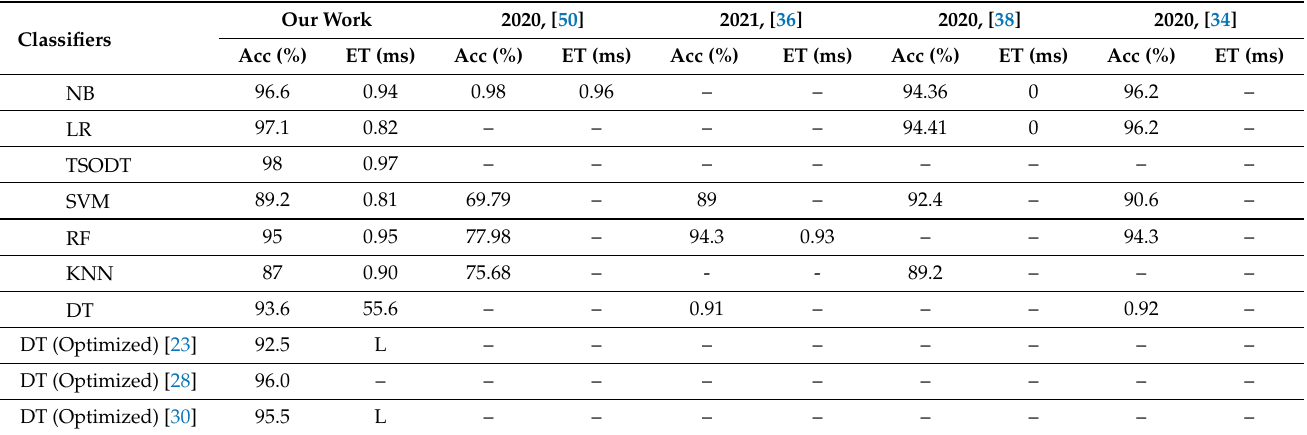
Table 3. Comparison to state-of-the-art